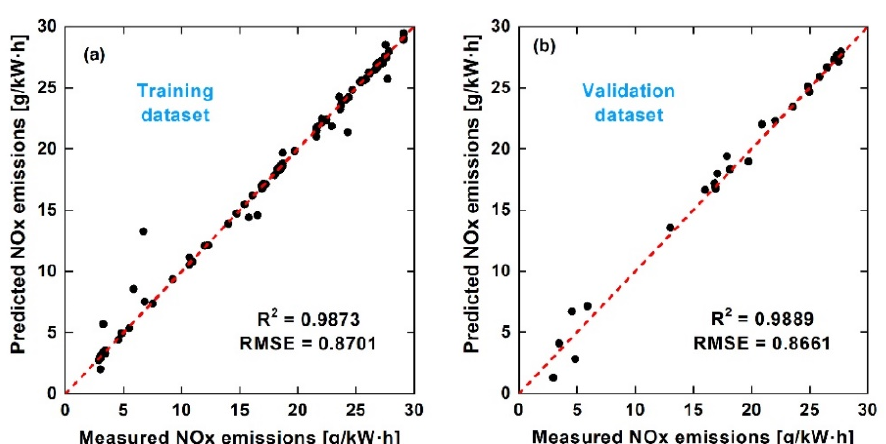
Figure 8. Comparison of SVR predicted results with measured data of NO x emissions. ( a ) Training dataset; ( b ) Validation dataset.